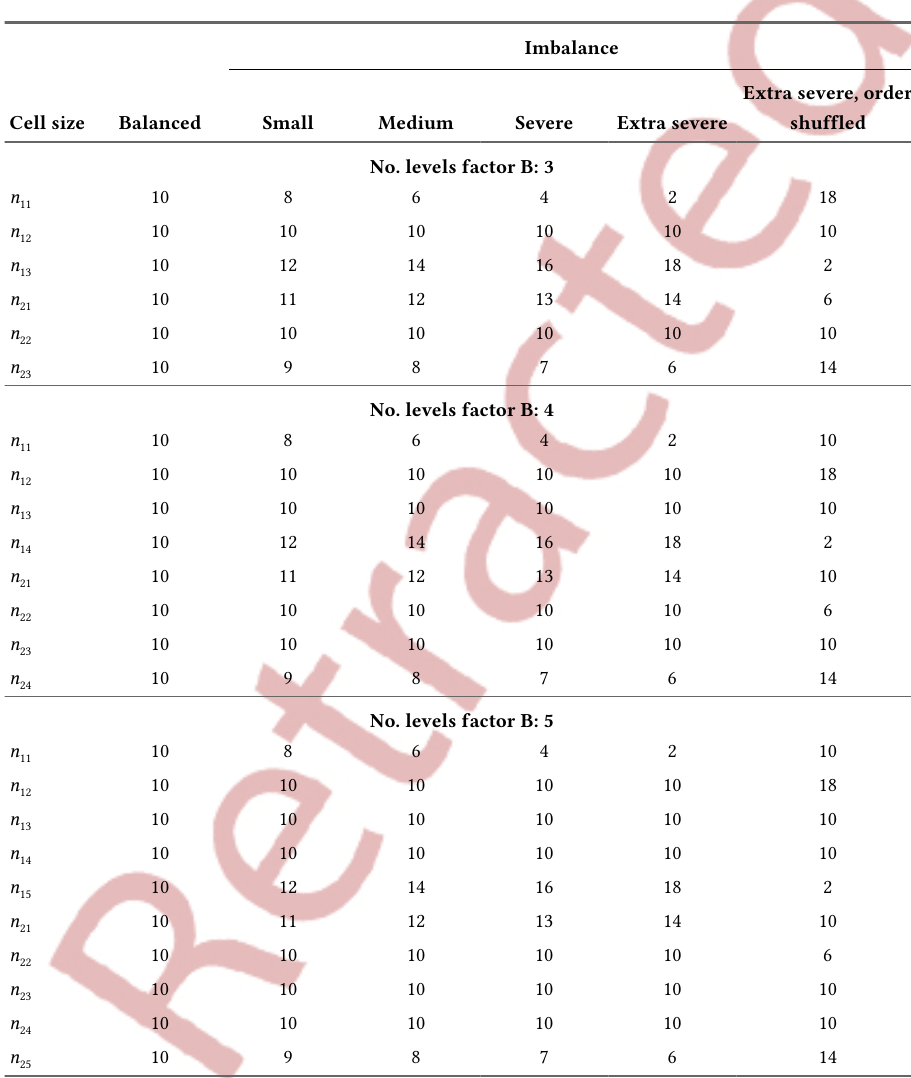
Cell Sizes for Different Degrees of Imbalance Under a Small Sample